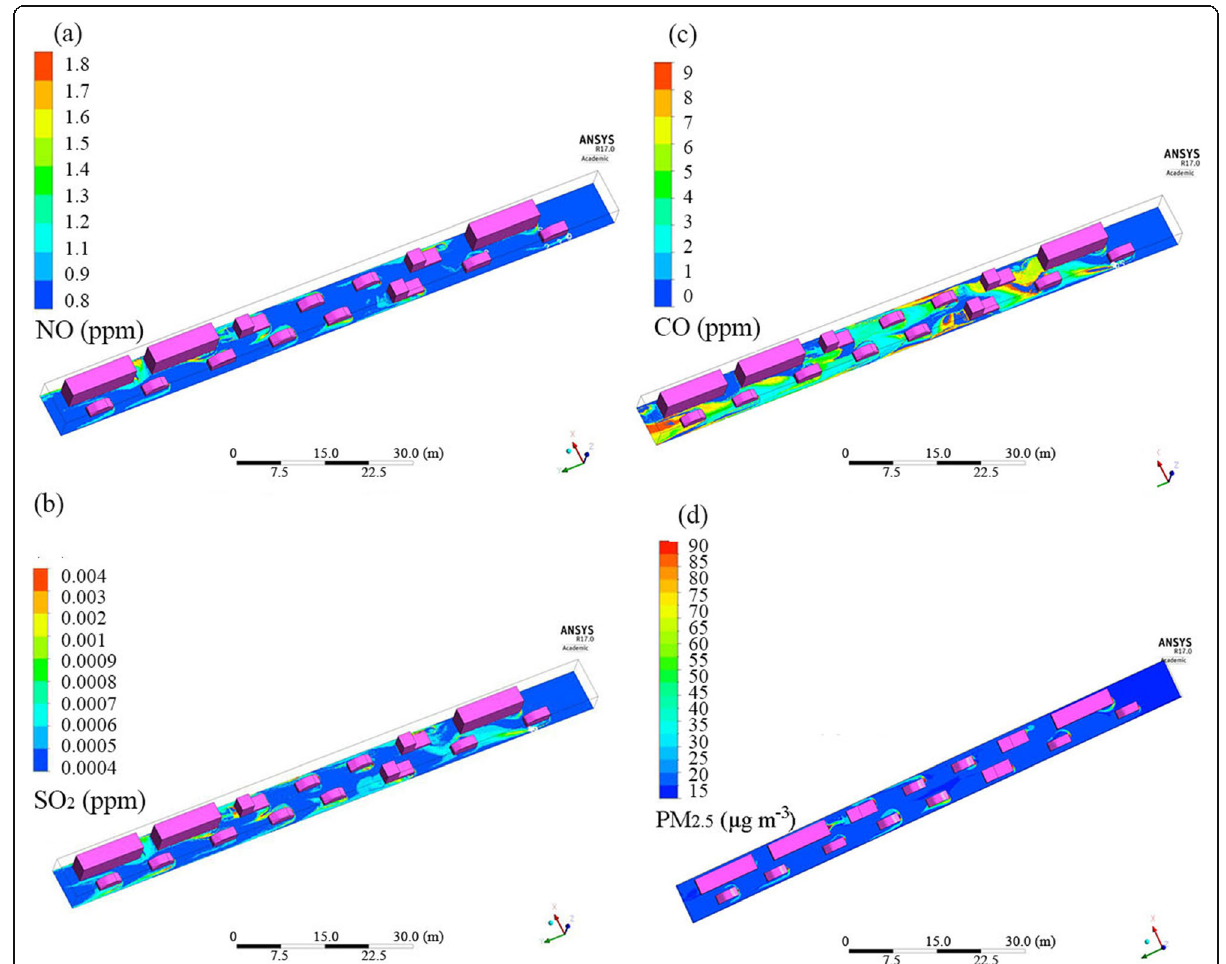
Fig. 5 a NO concentrations (ppm) on the weekend; b SO 2 concentrations (ppm) on the weekend; c CO concentrations (ppm) on the weekend; d PM 2.5 concentrations ( μ g m − 3 ) with the fan on the